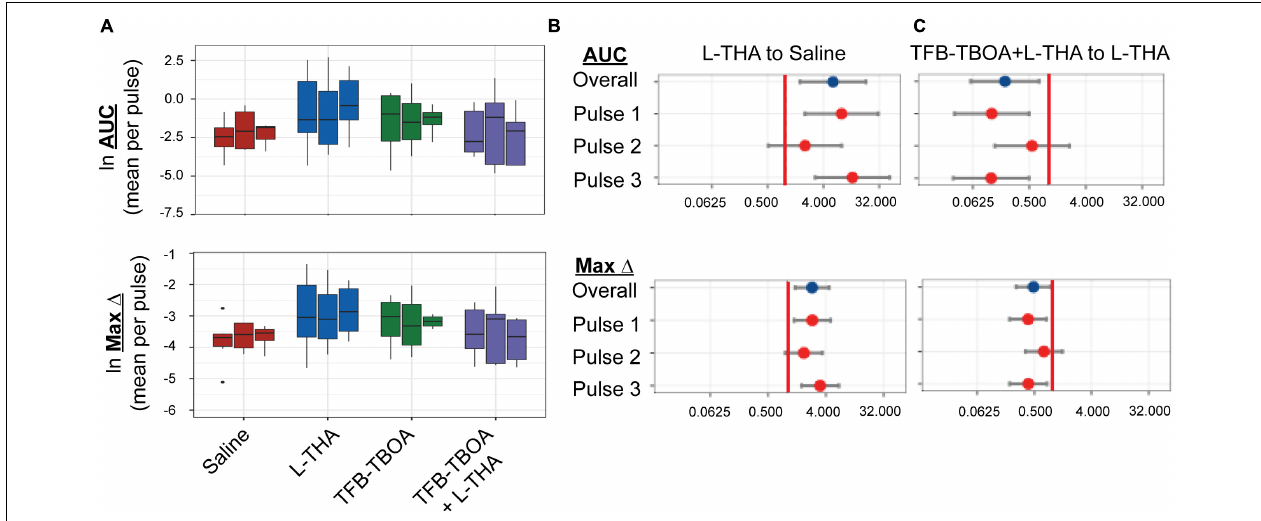
FIGURE 4 | Effects of saline, L-THA, TFB-TBOA, and TFB-TBOA with L-THA on arteriole diameter. Saline, L-THA (100 µ M), TFB-TBOA (2 µ M), or a combination of TFB-TBOA with L-THA were picospritzed near cortical arterioles. (A) Natural log (ln)-transformed raw data are presented as boxplots, using the mean of repeated measures from each animal. Raw values are from dilations (positive values), however, as data are ln-transformed, values > 1 are positive while values between 0 and 1 will appear on this scale as negative values (B,C) forest plots are included to visualize the results of the model and show the mean differences expressed as ratios of the effect observed with L-THA over that observed with saline (B) or TFB-TBOA with L-THA over that observed with L-THA (C) . The redline is at 1 and represents no difference. The data for saline are from 6 animals (3 males, 3 females) and are the same data as that presented in Figures 1 , 5 – 9 , the data for L-THA are from 12 animals (7 males, 5 females) and are also the same as those presented in Figures 5 – 9 . The data for TFB-TBOA are from 4 animals (2 males, 2 females) and the data for TFB-TBOA with L-THA are from 5 animals (3 males, 2